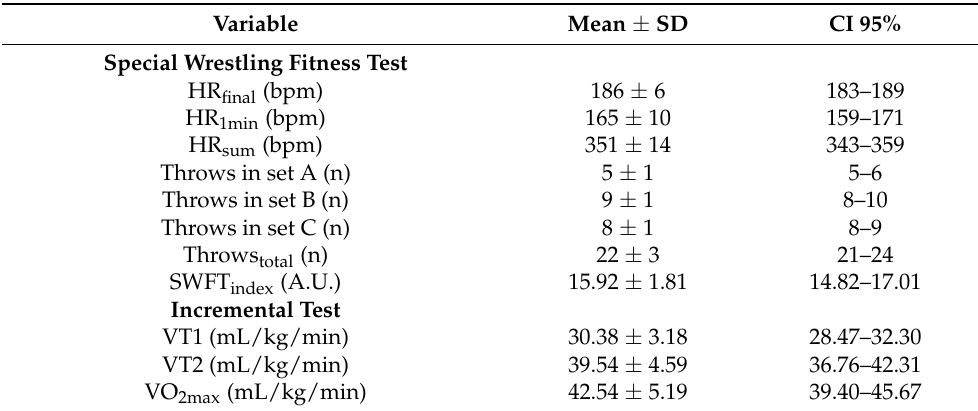
Table 1. Physiological response during the Special Wrestling Fitness Test and the incremental test in national-level